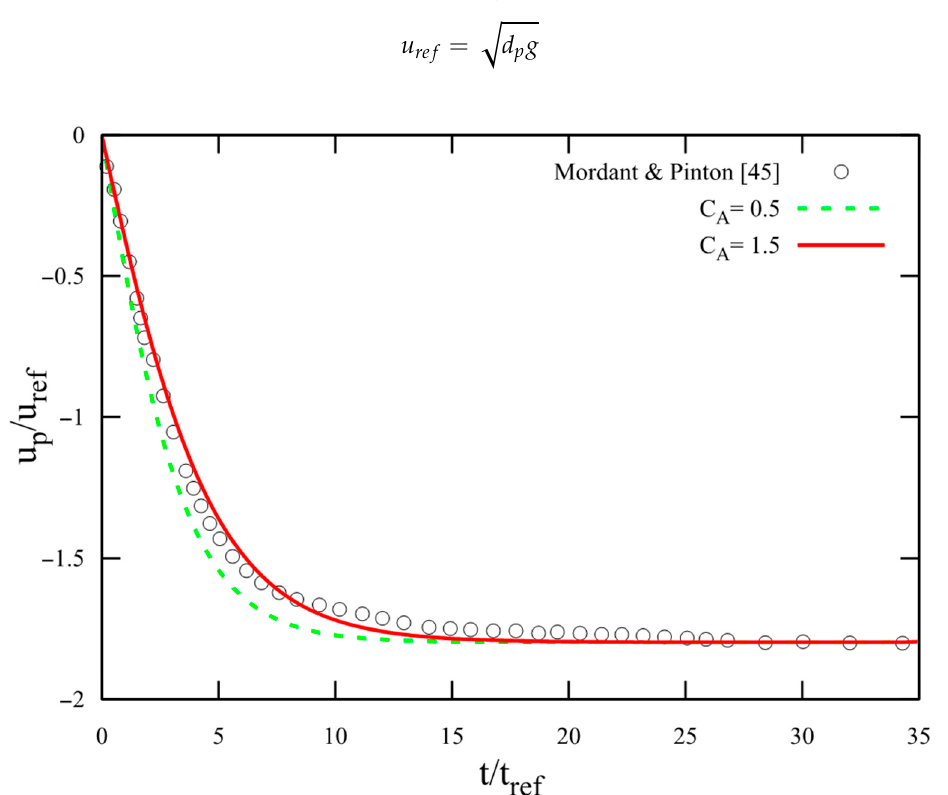
Figure 10. Influence of several integrated added mass coe ffi cients when using a particle volume expansion coe ffi cient of